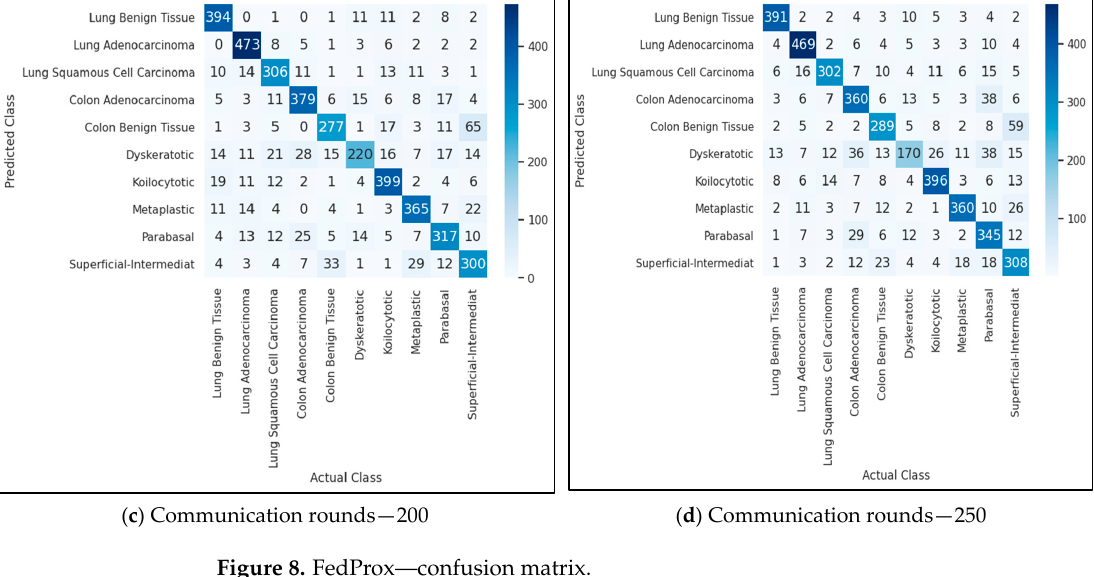
Figure 8. FedProx—confusion matrix. In order to visualize the difference between the performance of FedAvg and FedProx, we projected and showed the accuracy and loss of both algorithms in Figures 9 and 10.